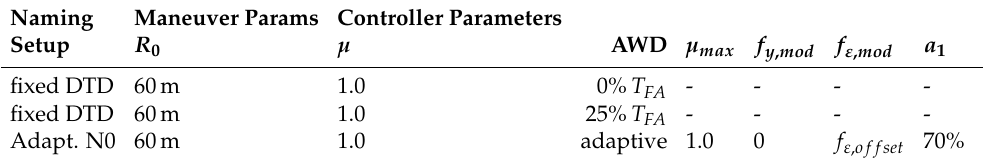
Table 5. Overview of the vehicle configurations and constraints for the investigation of the driving dynamics on dry pavement.